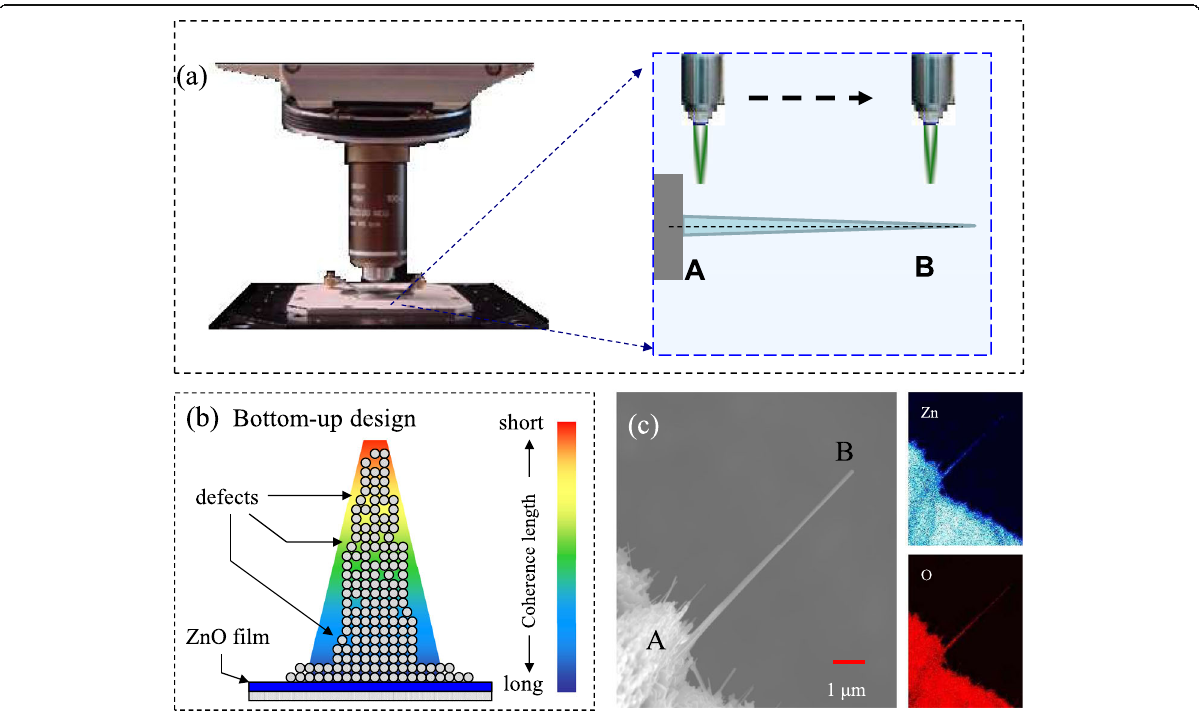
Fig. 2 a Schematic diagram of the Raman spatial mapping that is scanned from A (root) toward B (tip) along a single ZnO nanowire. b Conceptual diagram of defect distribution in ZnO nanowire. c SEM image of the selected ZnO nanowire at magnification of 10,000 and ( insets ) the corresponding WDS mappings of zinc and oxygen elements from A (root) to B (tip),